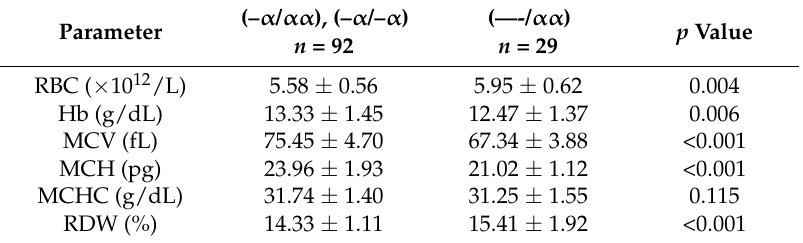
Table 5. Comparison of hematologic parameters of subjects with and without an α 0 allele. Data represent mean ± SD (standard deviation). p values less than 0.05 were considered statistically significant.